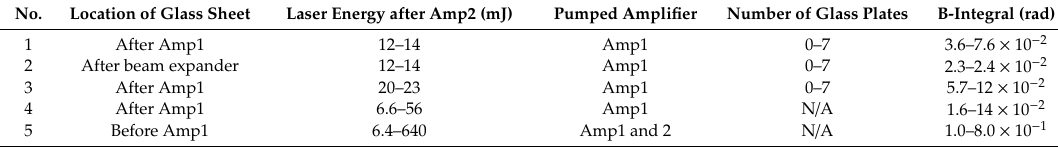
Figure 1. Experimental setup in J-KAREN-P. After the first chirped pulse amplification (CPA) and stretcher, the laser pulse is amplified with the optical parametric chirped-pulse amplifier (OPCPA) and Amp1 and Amp2 of the multi-pass amplifier. A glass sheet (0.15 mm thick) for post-pulse generation is placed between OPCPA and Amp1, or between Amp1 and Amp2. The glass plate (6.35 mm thick) is placed for increasing the B-integral value. The Nos indicate the experimental condition in Table 1. The temporal contrast is measured with self-referenced spectral interferometry (SRSI) and self-referenced spectral interferometry with extended time excursion (SRSI-ETE) after the compressor. Table 1. Experimental conditions when investigating the pre-pulse intensity in response to a variation of the B-integral. In the experiment of Nos. 1–3, the B-integral value is increased by adding the glass plates. The maximum reflection loss with seven pieces is ≈ 13%. In Nos. 4 and 5, the B-integral value is increased by increasing the laser energy. Note that in Nos. 4 and 5, no glass plate is added.